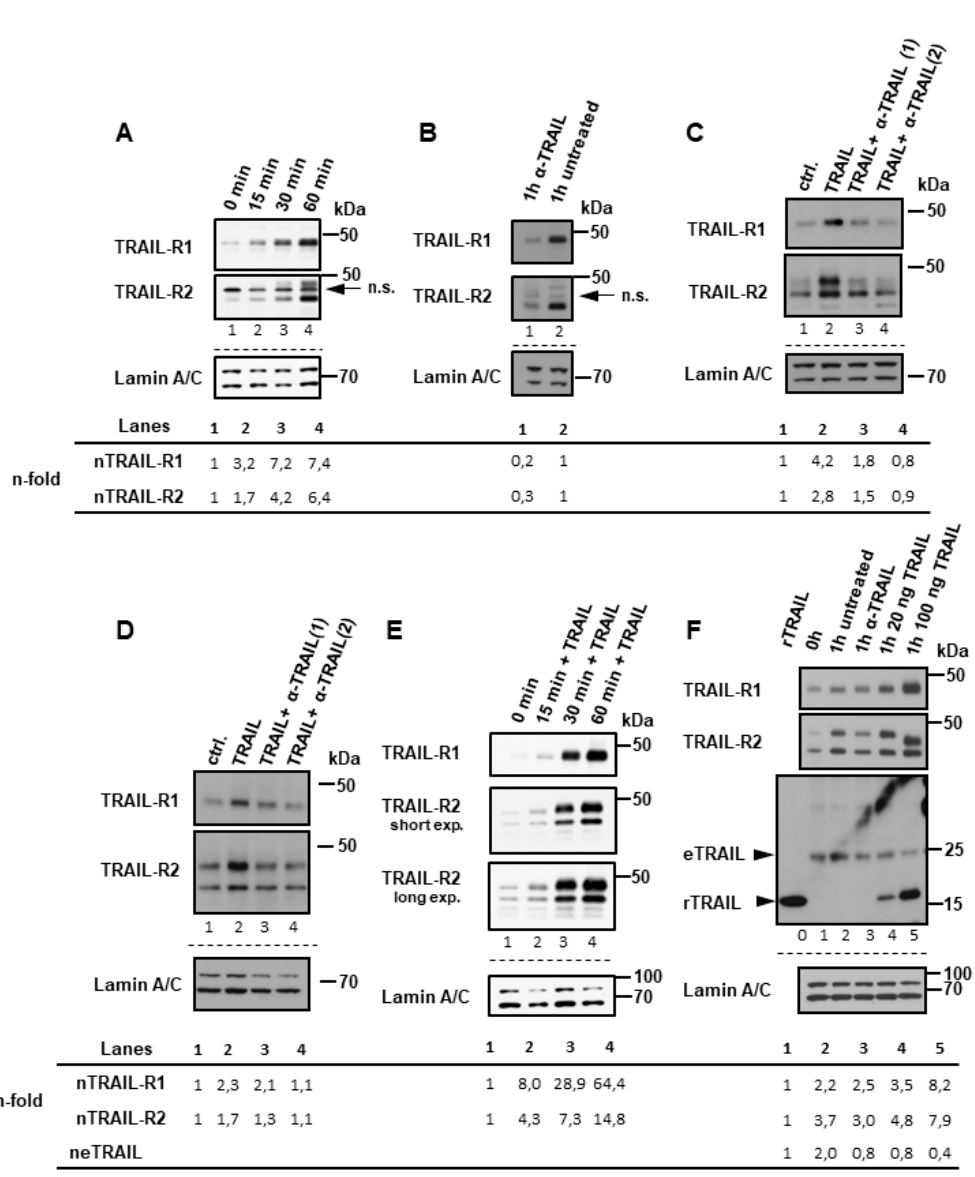
Figure 2. TRAIL receptors translocate to the nucleus in a ligand-dependent manner. Biotin labeling of surface proteins was done at 4 °C in Panc89 cells ( A – C ) and PancTu-I ( D – F ) cells. Receptor trafficking was restored by incubating cells in full medium at 37 °C for the indicated time points with or without anti-TRAIL neutralizing antibody ( α -TRAIL) and with or without different concentration of recombinant TRAIL. Nuclear fractions (NF) were isolated and biotinylated protein-complexes were affinity purified using streptavidin-conjugated beads. Precipitates were analyzed by Western blotting for the presence of TRAIL-R1, TRAIL-R2 ( A – F ) or endogenous (e) or recombinant (r)TRAIL ( F ). In lane “0” in ( F ), 35 pg of rTRAIL, which was used for stimulation was loaded. Protein lysates from nuclear fractions were immunoblotted for lamin A/C (NF marker) as control for the equal amounts of extracts used for purification of biotinylated-proteins. ( A ) Panc89 cells were incubated for indicated time periods at 37 °C without any additional stimulation. ( B ) Panc89 cells were incubated with or without α -TRAIL (during biotinylation and subsequent incubation at 37 °C). ( C ) Panc89 cells and PancTu-I cells ( D ) were treated for 1h with TRAIL or TRAIL and α -TRAIL in two different concentrations 1: 0.5 µg/mL; 2: 2.5 µg/mL). ( E ) PancTu-I cells were stimulated with 20 ng/mL of recombinant TRAIL for indicated time periods. ( F ) PancTu-I cells were treated or not with different concentration of recombinant TRAIL or left untreated in presence or absence of α -TRAIL. Densitometry-based quantification of TRAIL-R1, TRAIL-R2 and eTRAIL bands are shown below the blots. Bands intensities in relation to Lamin C were normalized to corresponding controls.